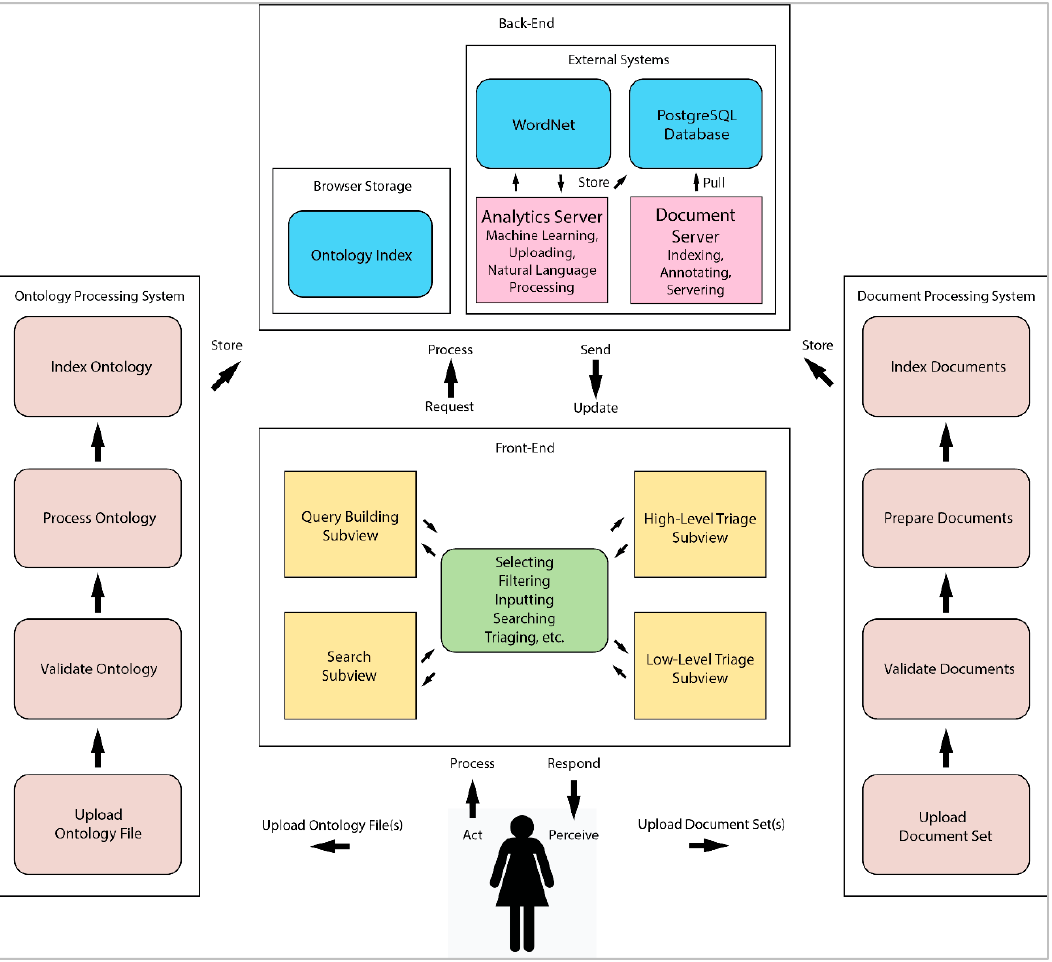
Figure 5. Depiction of the dynamic functional workflow of VisualQUEST.